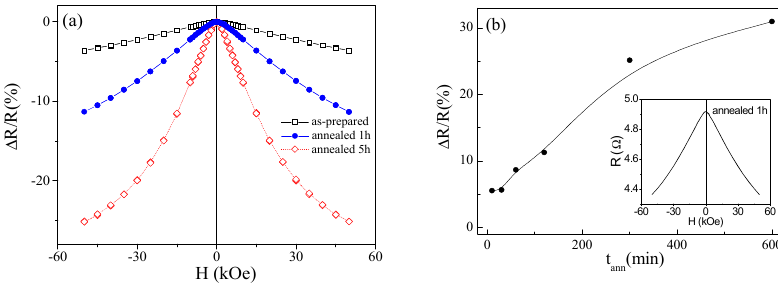
Figure 20. Effect of annealing ( T ann =400 °C) on GMR effect of Cu 90 Co 10 microwires ( a ) and dependence of GMR effect on annealing time ( b ). Real resistance variation with magnetic field in the sample annealed at 400 °C for 1 h measured at 5 K is shown in the inset of Figure 2b. 5K 80K